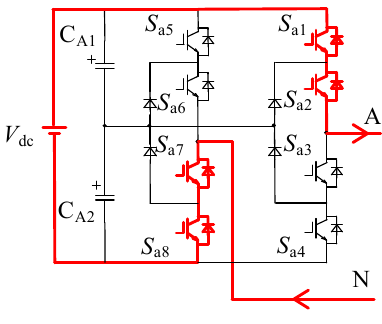
Figure 2. The circuit of pulse mapping 1.